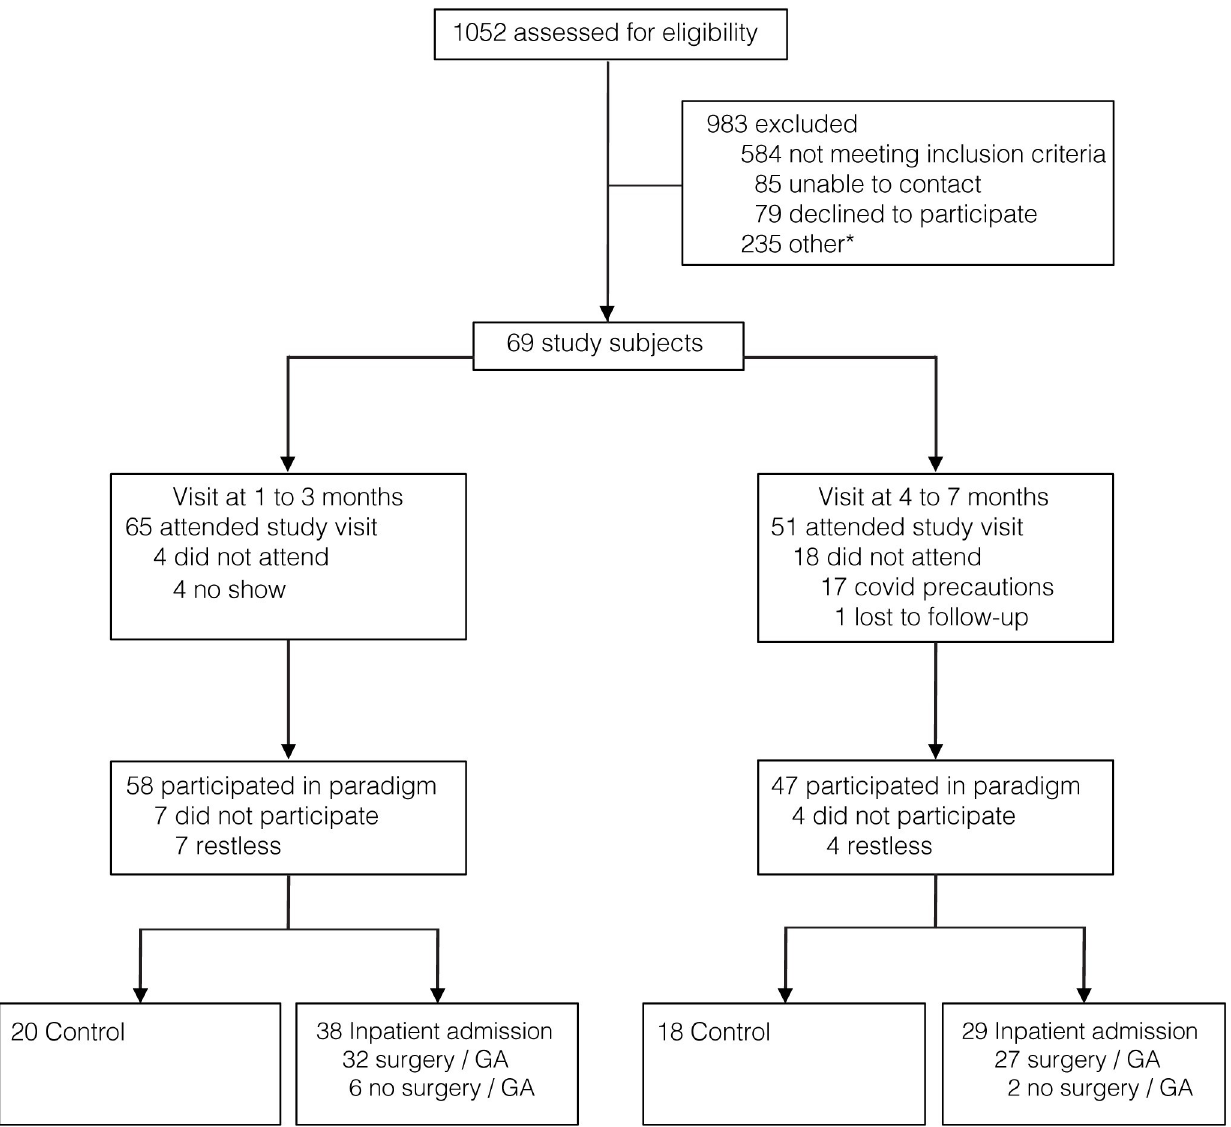
Fig 1. Flow of participants through the study. � ‘Other’ indicates children who did not meet stratified recruitment targets at the time of